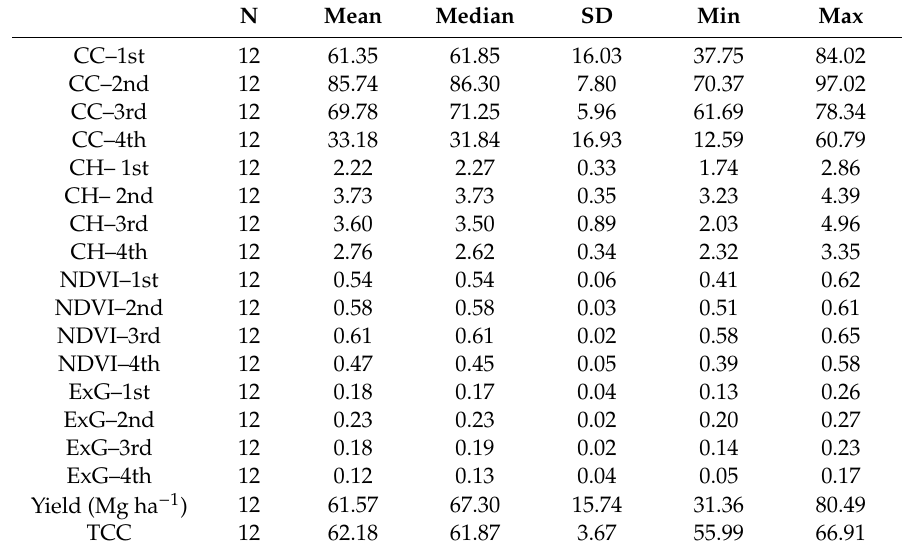
Table 2. Descriptive statistics of canopy cover (CC), canopy height (CH), Normalized Di ff